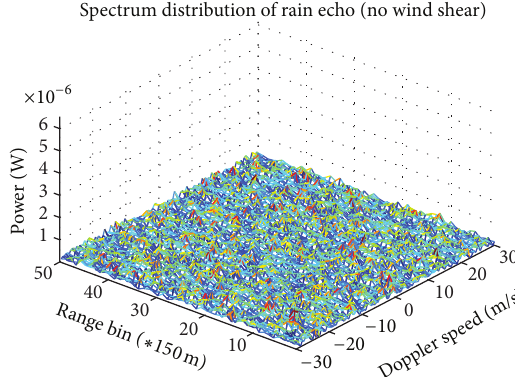
Figure 3: Rain Echo Spectrum Distribution of no Wind Shear.